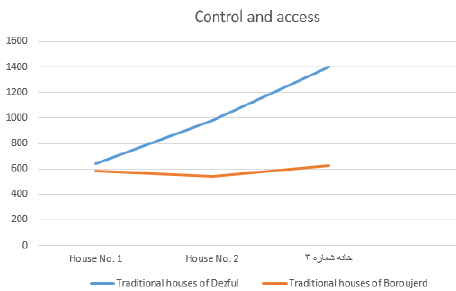
Figure 6. Measuring control and access in traditional houses in Dezful and Boroujerd (source: compiled by the authors)